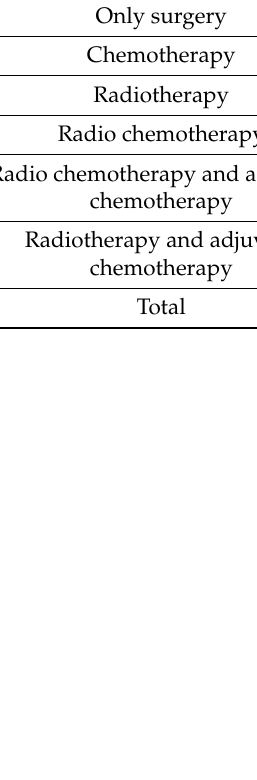
Table 5. Crude and adjusted hazards